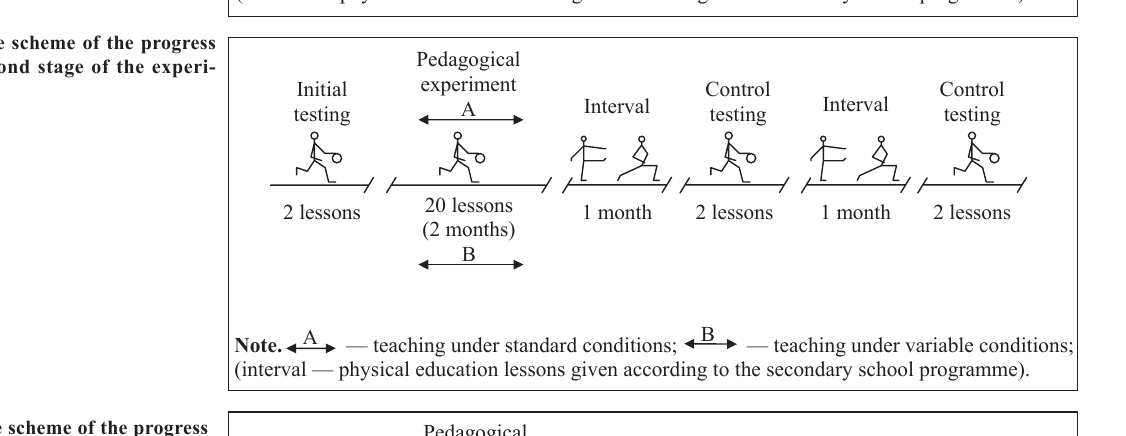
Fig. 3. The scheme of the progress of the third stage of the experi-